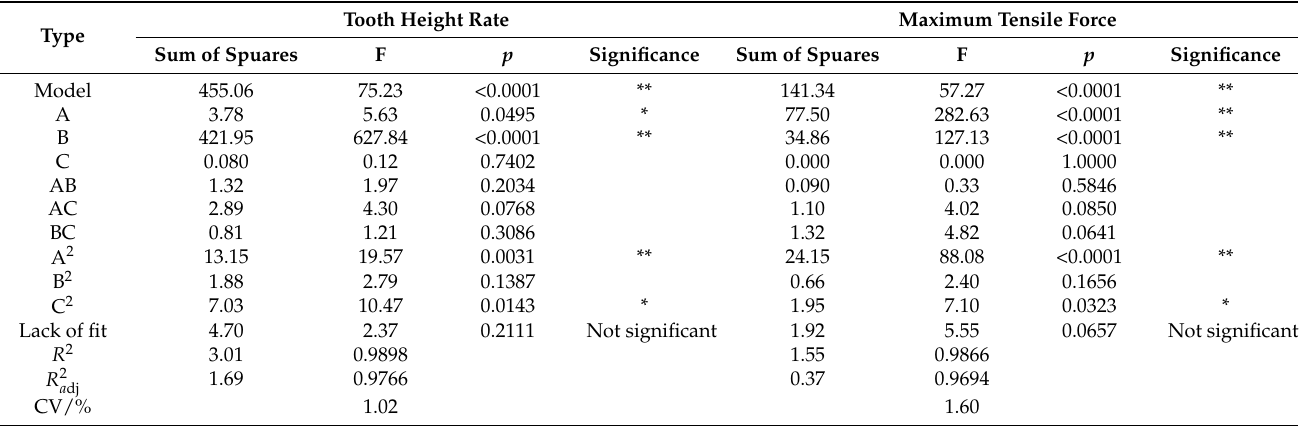
Table 5. ANOVA for response surface